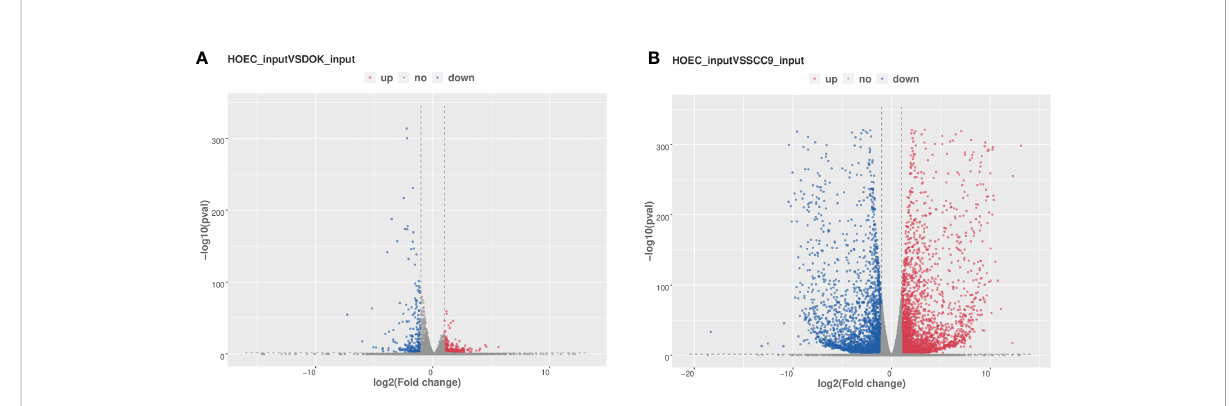
FIGURE 4 Volcano plots of differentially expressed genes in DOK and SCC-9 cells compared with HOEC cells. (A) HOEC VS DOK; (B) HOEC VS SCC-9. | log 2 FC| ≥ 1.0 and p < 0.05.